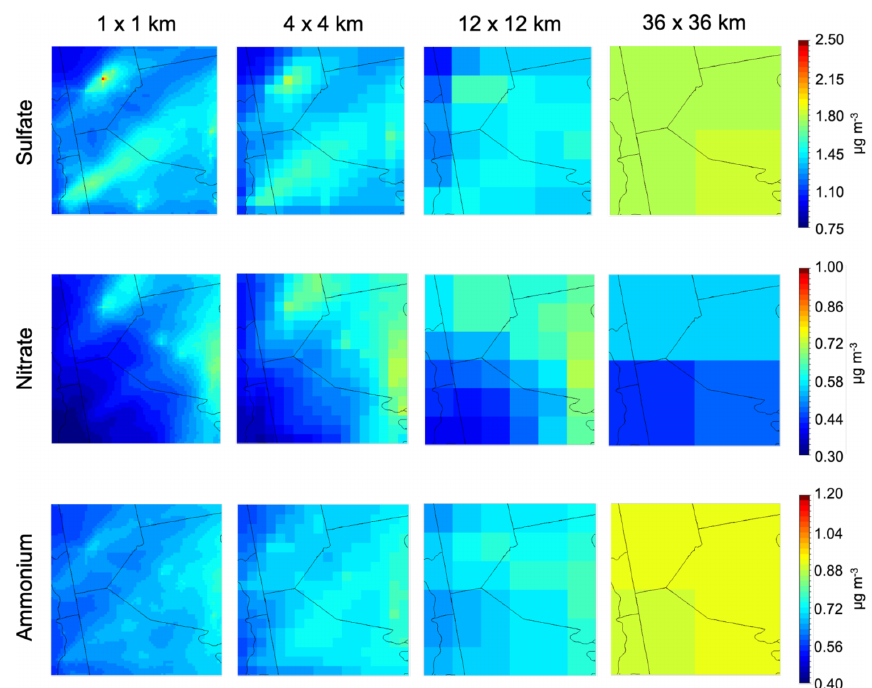
Figure 7. Average predicted concentration of PM 2 . 5 sulfate, nitrate, and ammonium at a 36 × 36, 12 × 12, 4 × 4, and 1 × 1km during July 2017. Different color scales that do not start from zero are used for the various